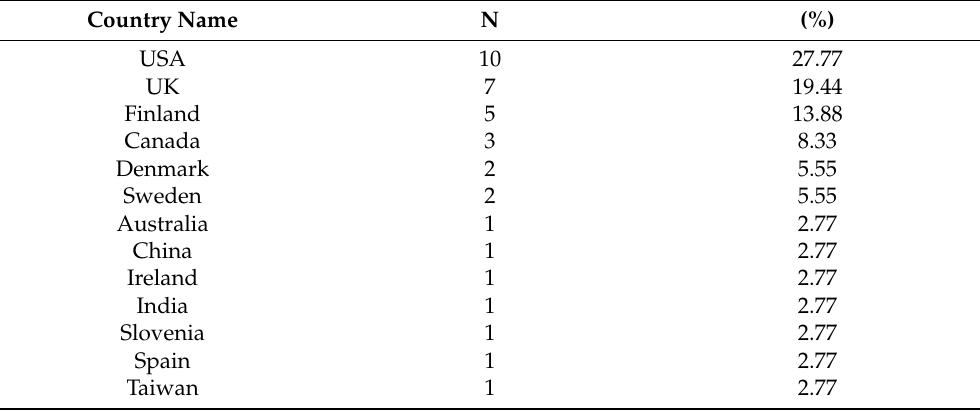
Table 2. Distribution of the papers based on the country of the corresponding author.